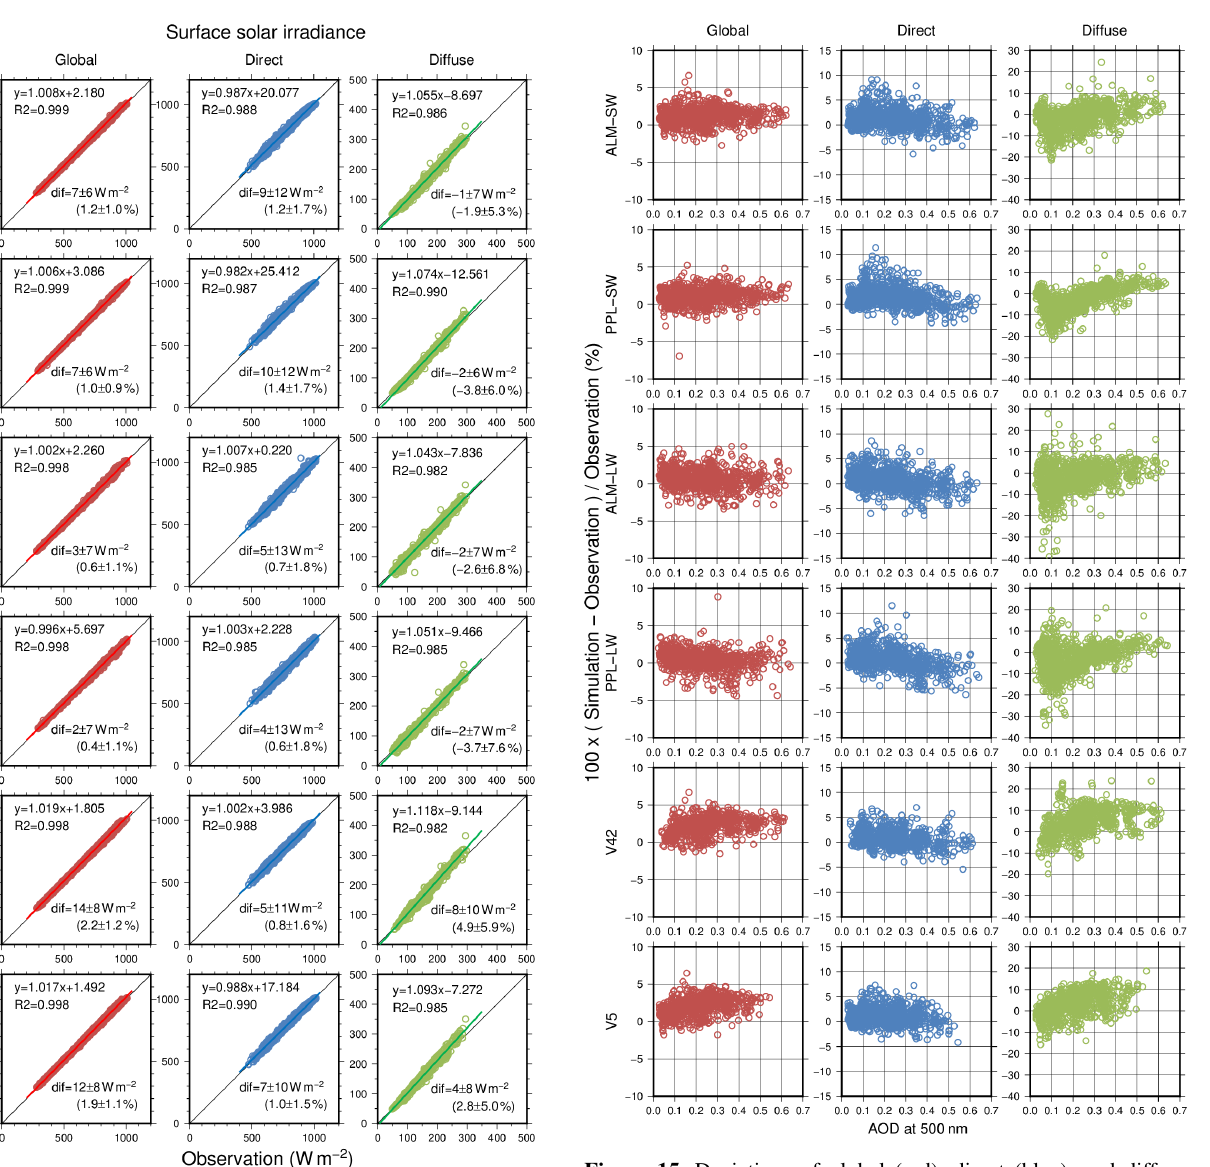
Figure 15. Deviations of global (red), direct (blue), and diffuse (green) solar irradiances between the measurements and the simula- tions using ALM-SW, ALM-LW, PPL-SW, PPL-LW, V42, and V5 retrieval results as a function of the aerosol optical depth at